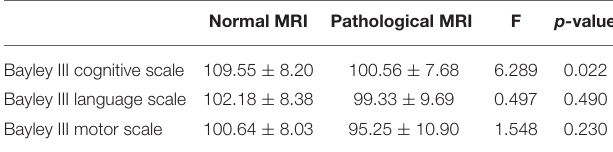
TABLE 5 | Neurodevelopmental outcomes of 30 neonates at 12 months of